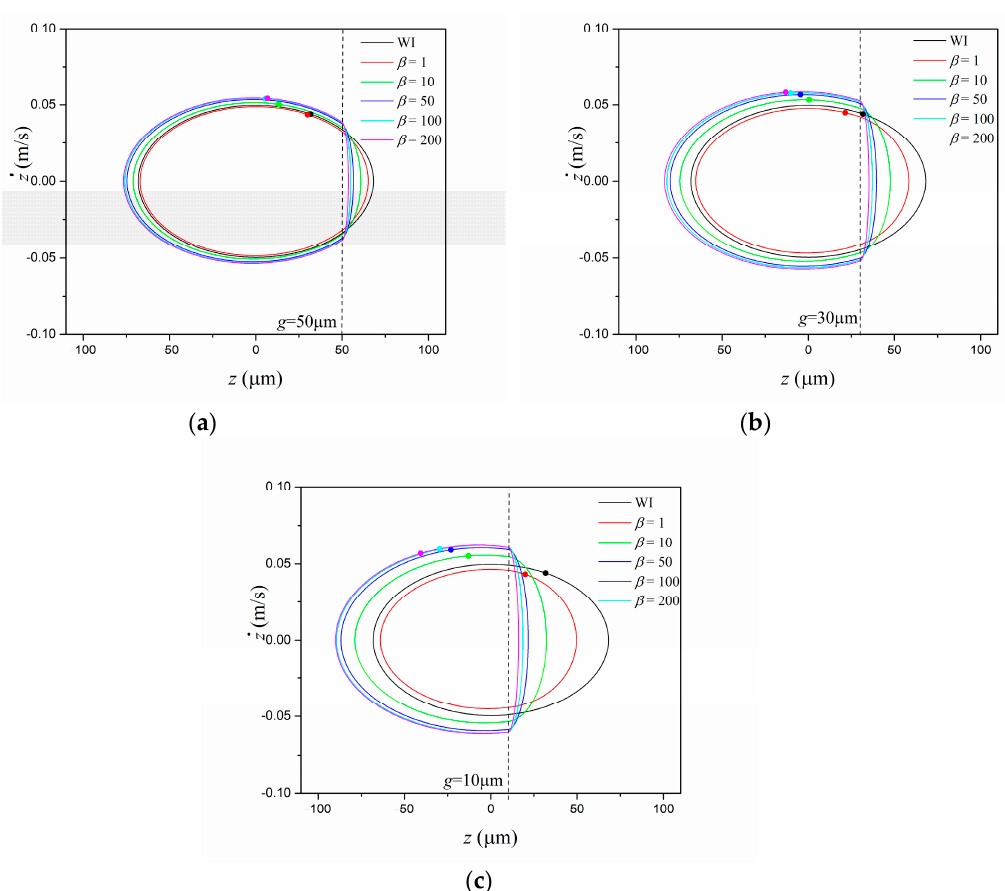
Figure 5. Phase spaces and Poincaré sections at resonance frequencies. A comparison between a linear model without impacts (WI, using 𝑔 = 70 μ m) and a system incorporating impacts with different values of 𝛽 : ( a ) 𝑔 = 10 μ m, ( b ) 𝑔 = 30 μ m, and ( c ) 𝑔 = 50 μ m .